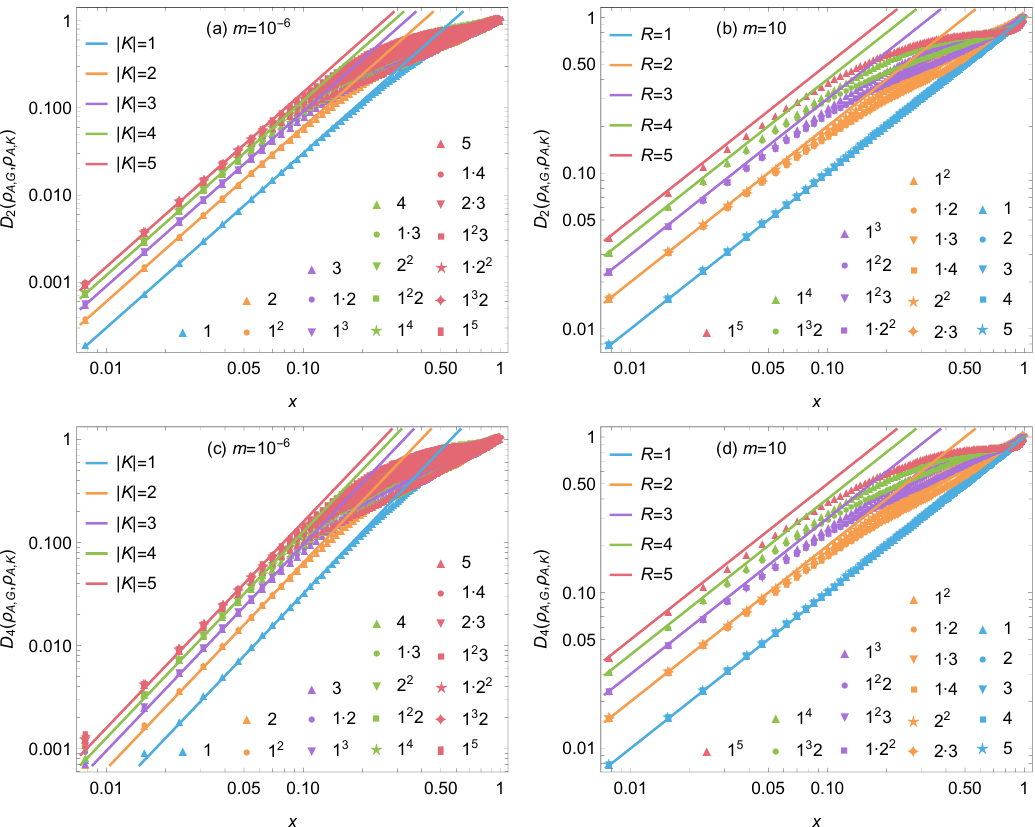
Figure 9 . The short interval expansion of the Schatten distance in the massless (left column) and extremely massive (right column) limits of the 2D free non-compact bosonic theory (lines) and the Schatten distance in the gapless (left column) and extremely gapped (right column) limits of the harmonic chain (symbols). We have set L = 128